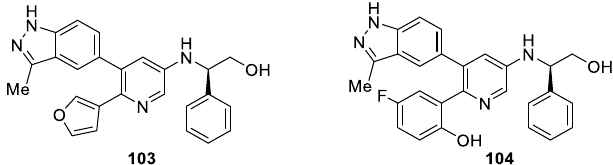
Figure 16. Chemical structures of pyridin-3-amine derivatives 103 and 104.